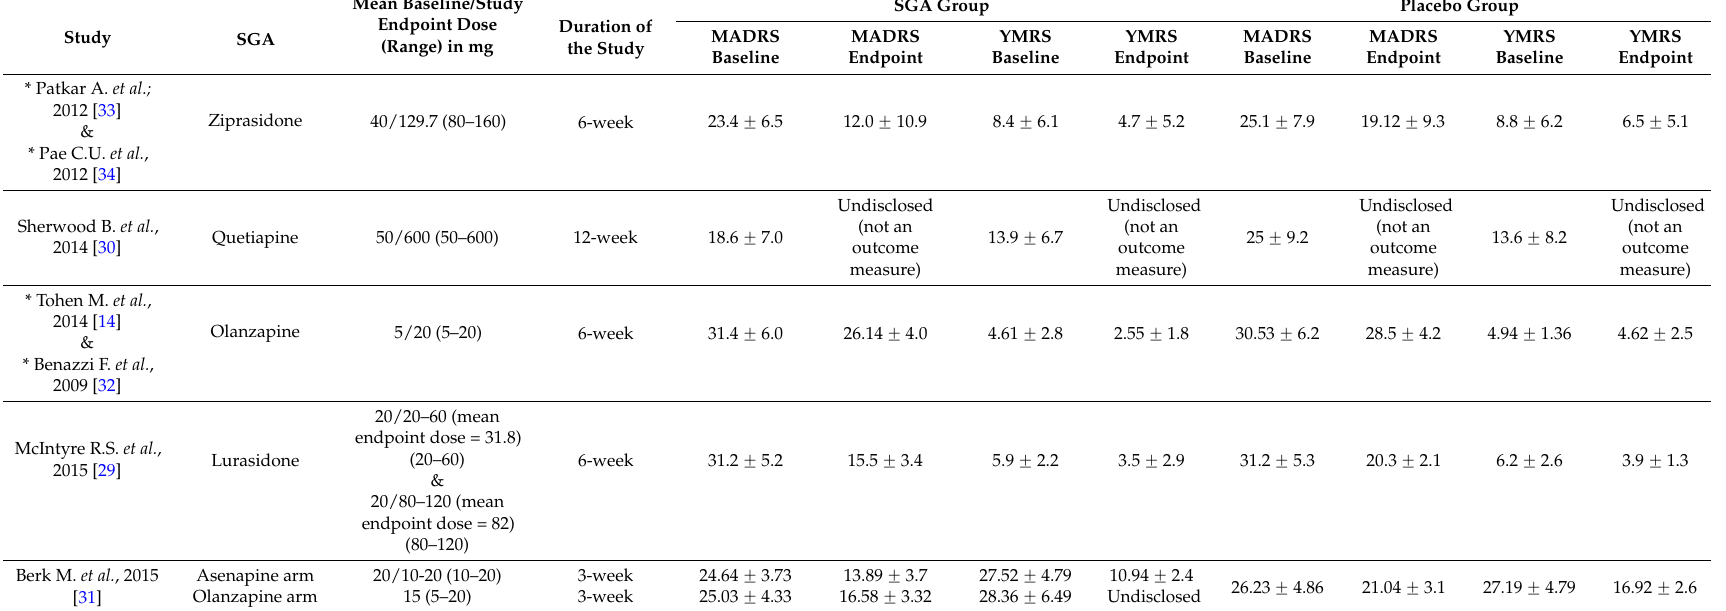
Table 1. Essential characteristics of the studies included in the